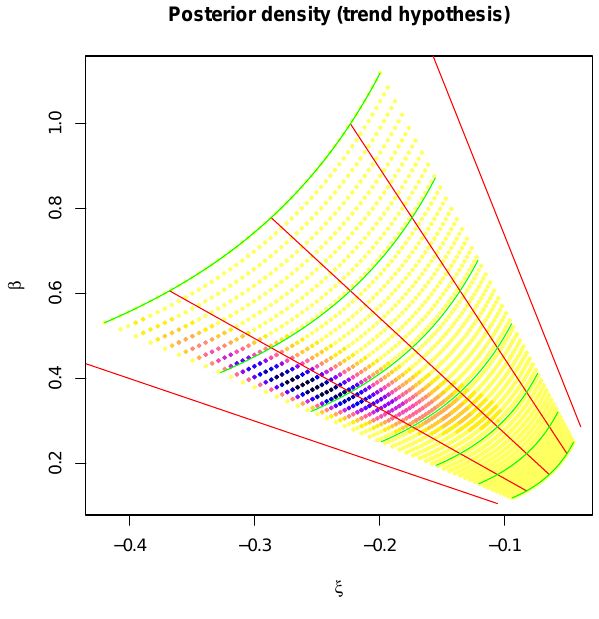
Fig. 6. Pixel map of posterior joint density for GPD parameters: usual parameterization. Parameter ξ is non-dimensional and β has units proportional to the units of the excesses ( Y ).